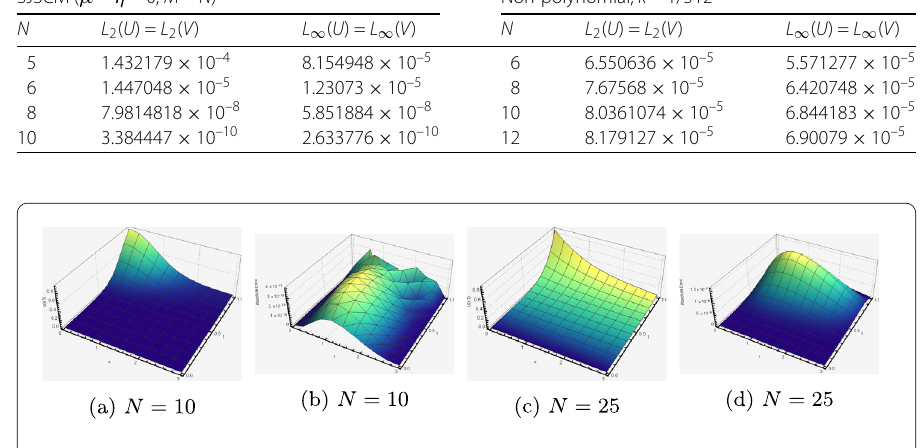
Table 17 L 2 and L ∞ error norms for u ( x , t ) = v ( x , t ) of Example 3 when 0 ≤ x ≤ 3, α 1 = α 2 = 0.5 SJSCM ( μ = η = 0, M = N )